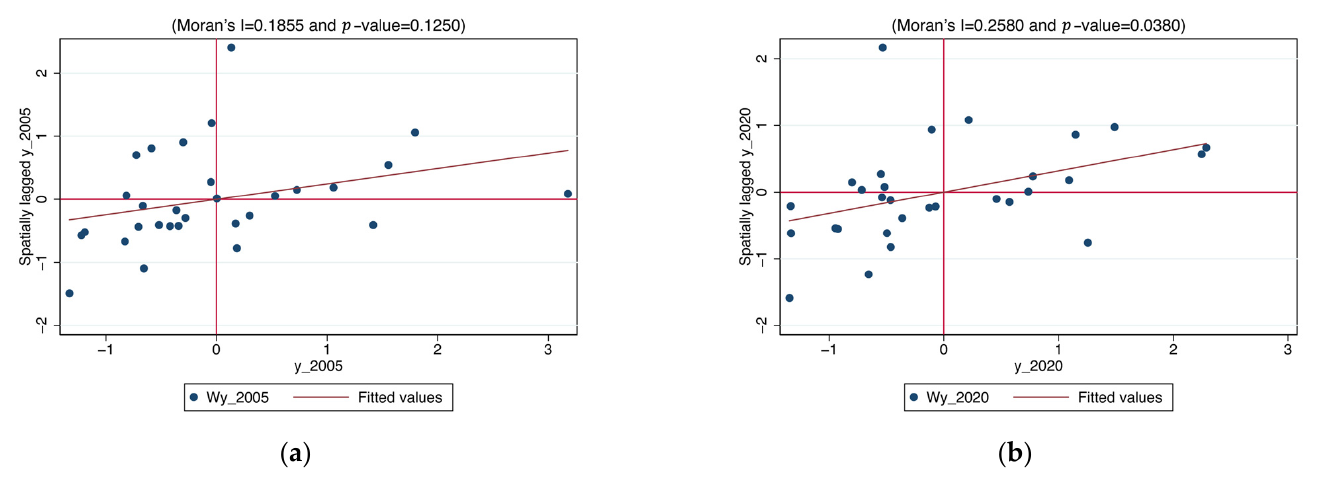
Figure 3. Moran’s I scatter plots for 2005 and 2020, ( a ) Moran’s I scatter plots for 2005; ( b ) Moran’s I scatter plots for 2020. The first and third quadrants indicate that high-observed-value areas are surrounded by high-observed-value areas (H–H) and low-value areas are surrounded by low-value areas (L–L), respectively, and the second and fourth quadrants indicate that low-value areas are surrounded by high-value areas (L–H) and high-value areas are surrounded by low-value areas (H–L), respectively. Table 3. The results of